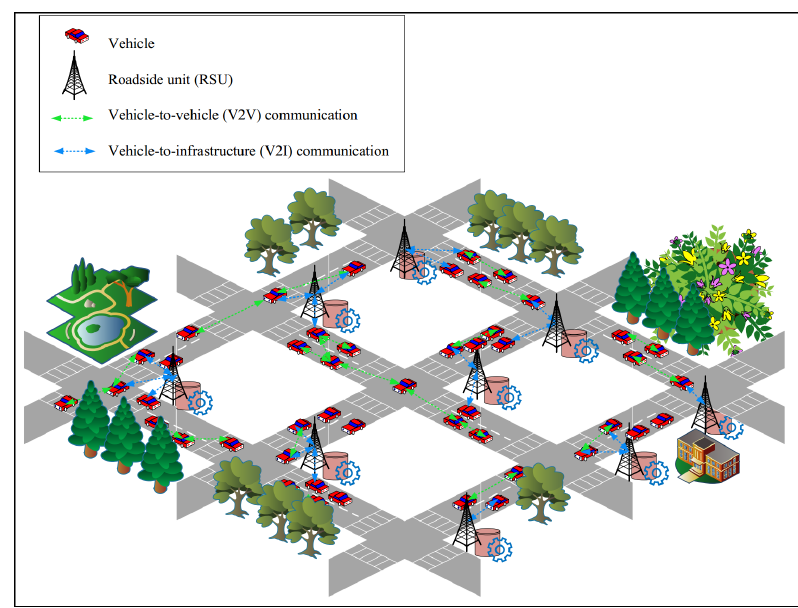
Figure 3. Network model in